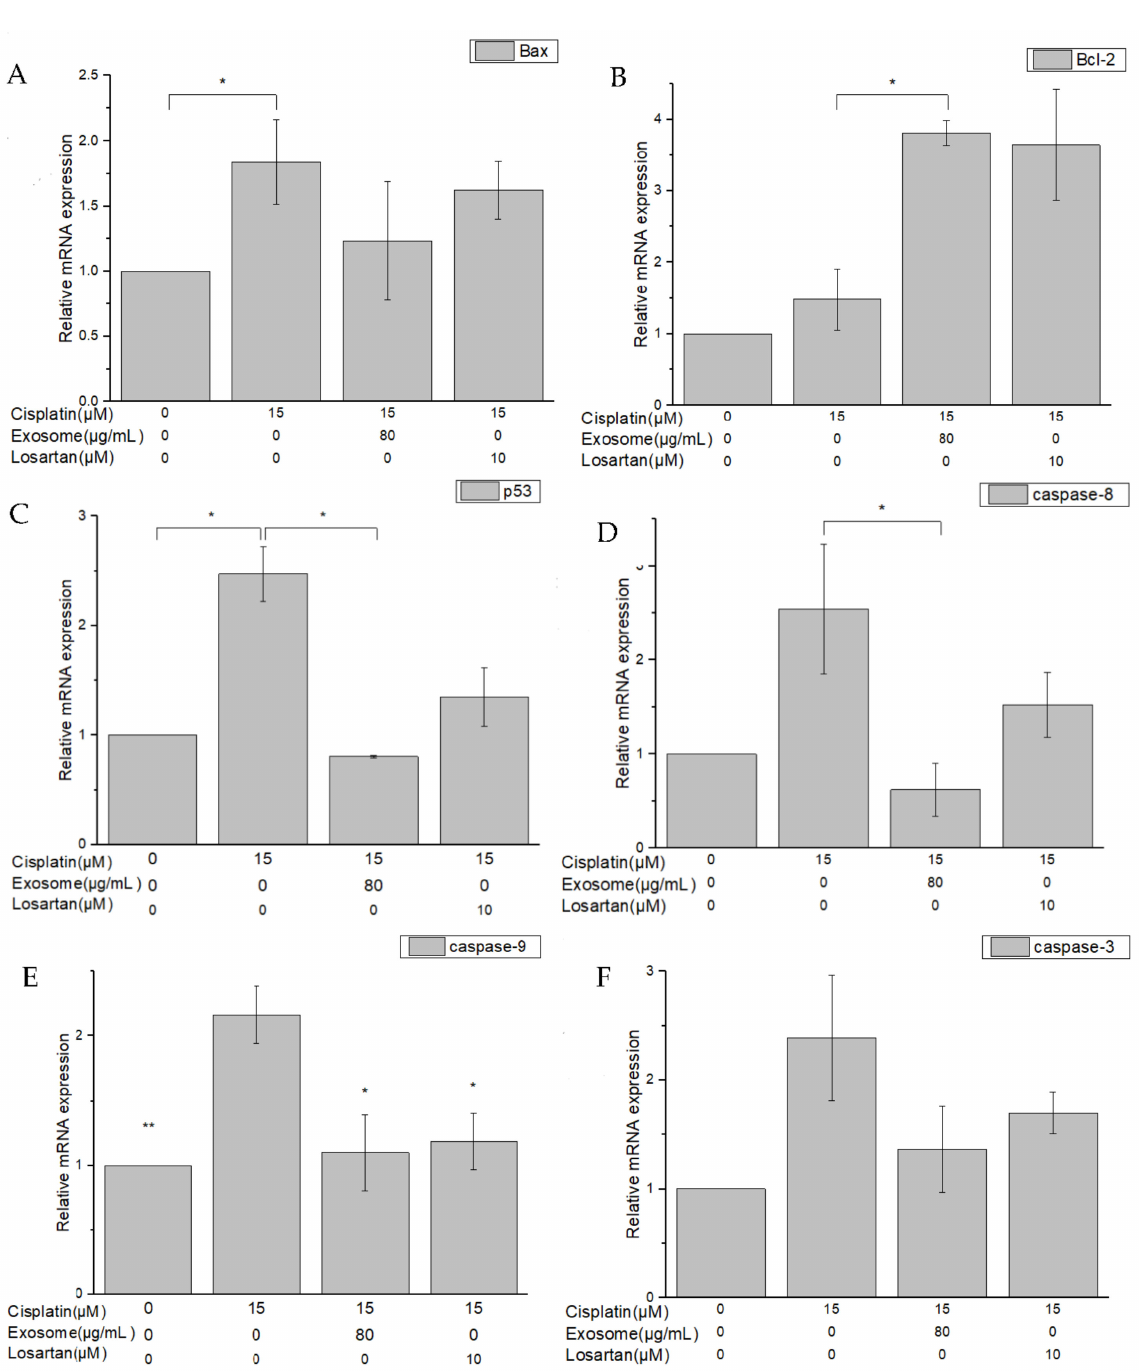
Figure 7. Gene-expression levels of Bax ( A ), Bcl-2 ( B ), p53 ( C ), caspase-8 (CASP8) ( D ), CASP9 ( E ), and CASP3 ( F ) in cisplatin-treated NRK-52E cells after pretreatment with SCAP-ex or losartan, measured via qRT-PCR assay. Values are expressed as mean ± SD ( n = 3), * p < 0.05; ** p < 0.01 for compared with cisplatin-treated group. Bax, Bcl-2 associated X; Bcl-2, B-cell lymphoma-2; qRT-PCR, quantitative reverse transcription–polymerase chain reaction; SCAPs, stem cells from the apical papilla; SCAP-ex, SCAP-derived